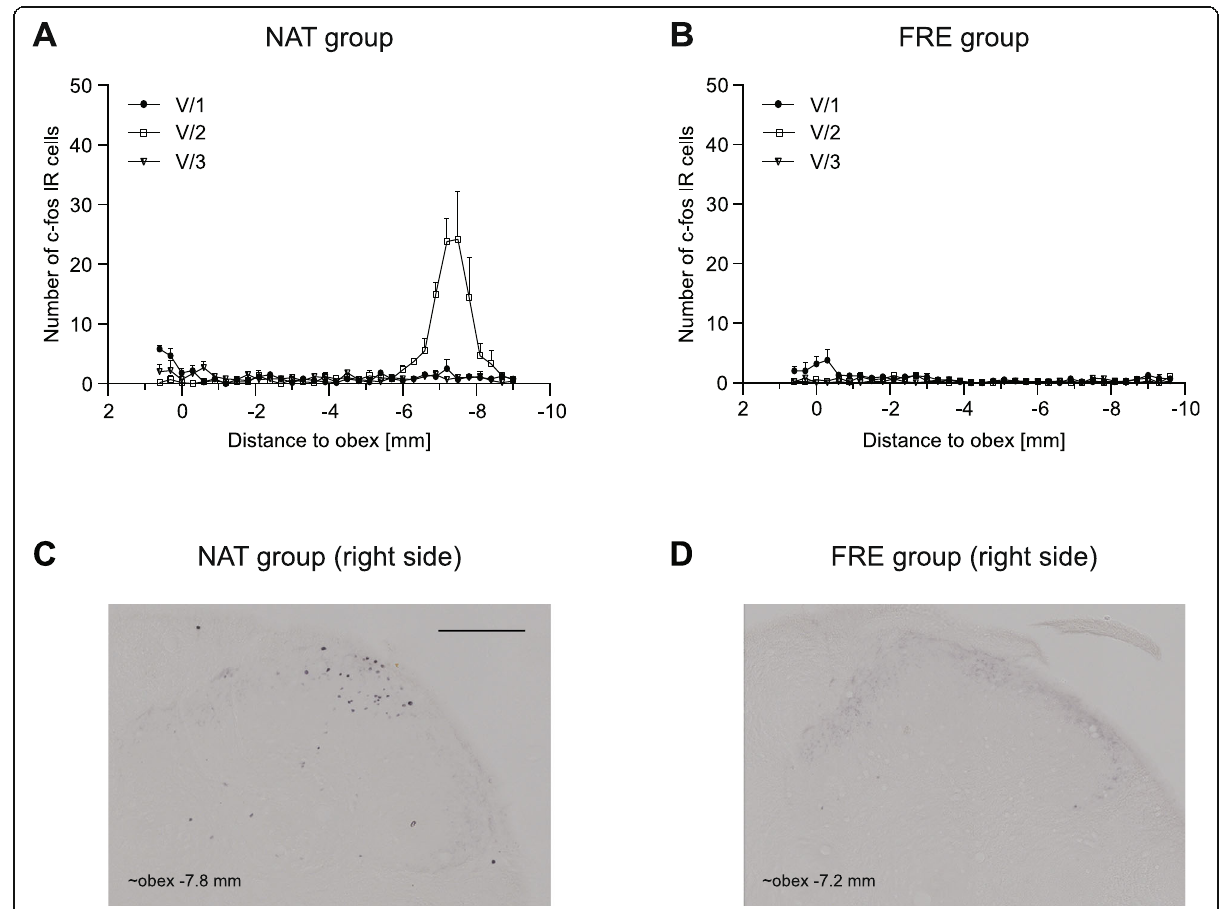
Fig. 2 Diagrams show the mean number of c-Fos IR neurons in the dorsal horns in NAT a and FRE b groups. Representative photomicrographs of the dorsal horn from NAT c and FRE groups d . Scale bar: 200 μ m. Use of stereotaxic frame caused robust increase of c-Fos positive cells in the area corresponding to maxillary nerve in NAT group. Number of c-Fos IR cells was minimal in FRE group (maximal cell number 3.83 ± 1.68 in the ophthalmic nerve area) (mean +